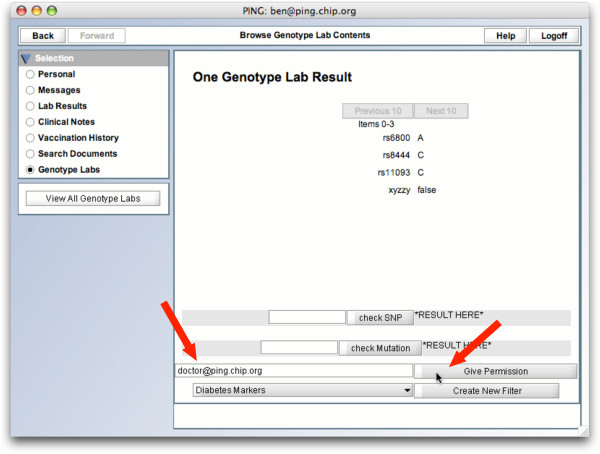
GenePING permission granting. Once this filtered document is created, a patient can grant read permission on this new document to his doctor.